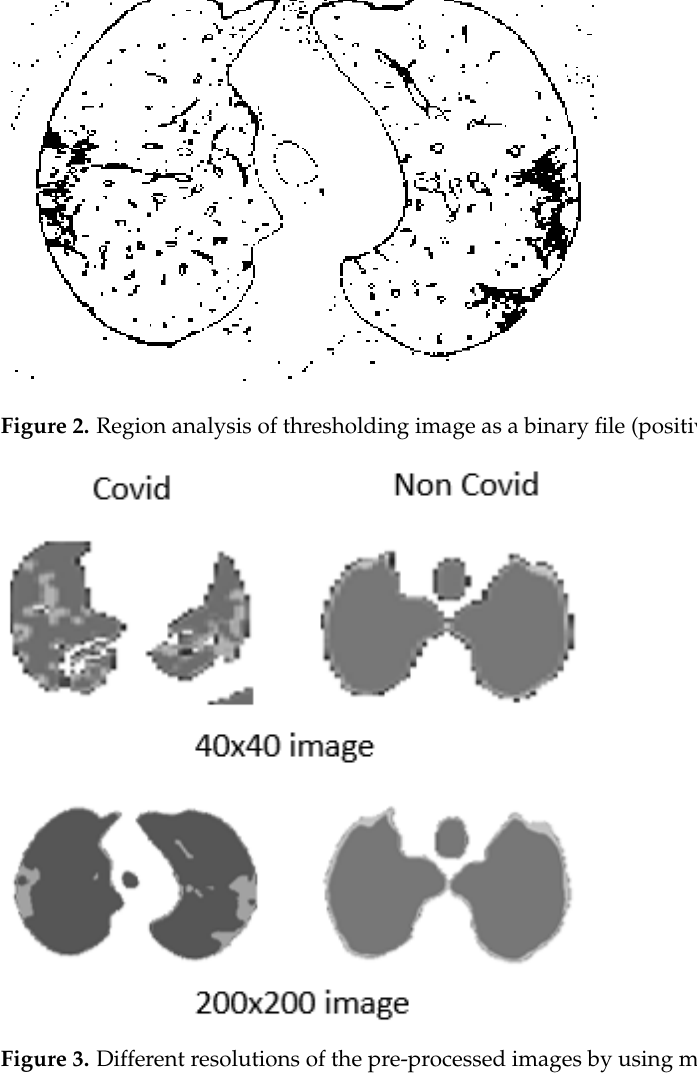
Figure 3. Different resolutions of the pre-processed images by using multi-level thresholding.